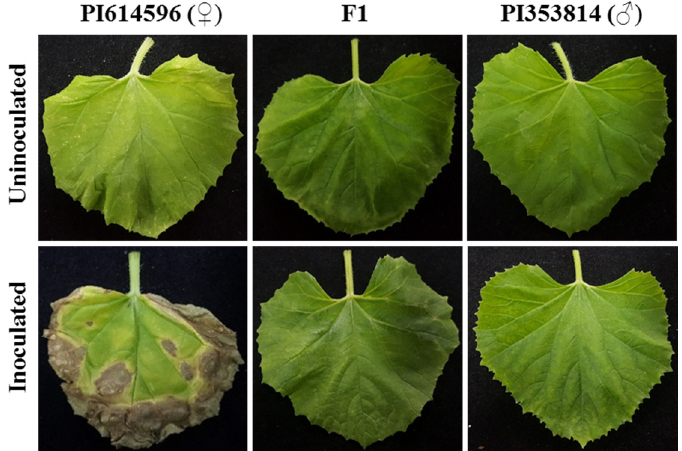
Figure 1. Bacterial fruit blotch phenotypes on leaves of the two parental melon accessions, PI 353814 (resistant) and PI 614596 (susceptible), and their F 1 hybrid (resistant) 12 days after inoculation with A. citrulli strain KACC18782, as compared to uninoculated controls. All leaves were detached just before the photographs were taken.